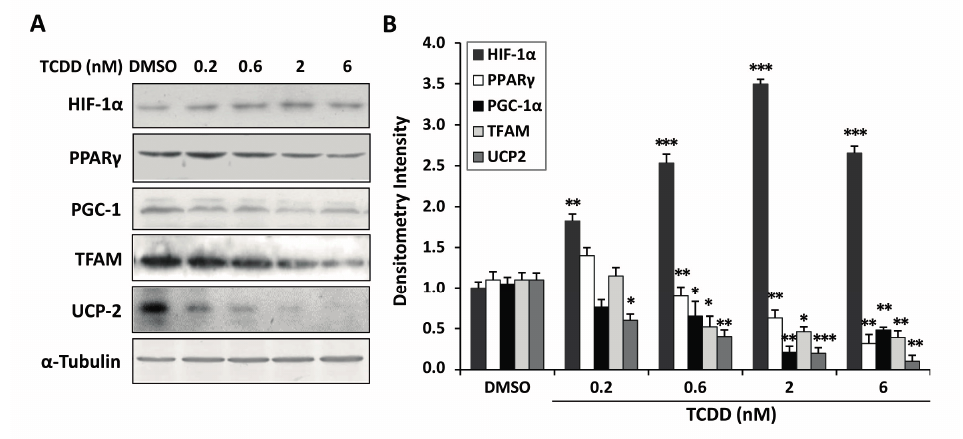
Figure 5. Peroxisome proliferator-activated receptor γ (PPAR γ ) and PPAR γ coactivator-1 α (PGC-1 α ) are targets of TCDD. ( A ) The expression profiles of HIF-1 α , uncoupling protein 2 ( UCP2 ), PPAR γ , PGC-1 α , and mitochondrial transcription factor (TFAM) were assessed by western blotting; ( B ) The protein levels were quantified by densitometry. Reduced expression of PPAR γ , PGC1 α , TFAM , and UCP2 was found in the TCDD-treated trophoblastic cells. The plots are the mean ± S.D. ( n = 3). * p < 0.05; ** p < 0.01; *** p < 0.001 compared with each control group.